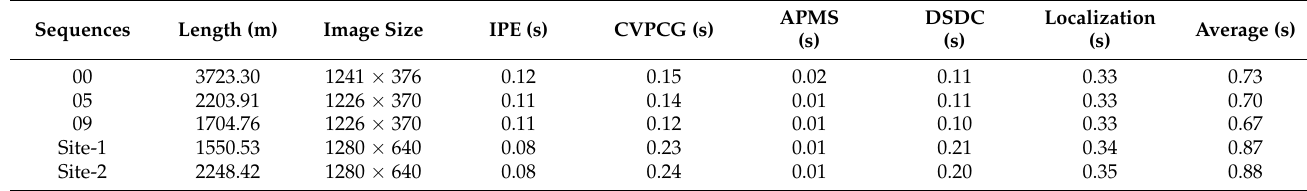
Table 3. Time performance of each localization process by the proposed